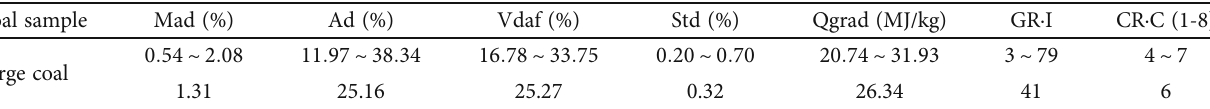
Table 1: Raw coal industry analysis results.